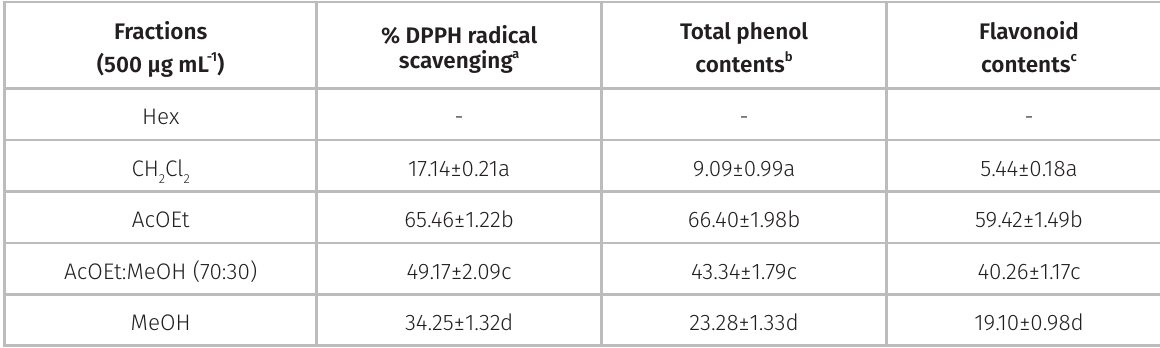
Table IV. DPPH radical scavenging activity and determination of total content of phenols and flavonoids in different fractions (N-Hexane=Hex, Dichloromethane = CH methanolic extract of C. antisyphiliticus at concentration of 500 µg mL -1 ).